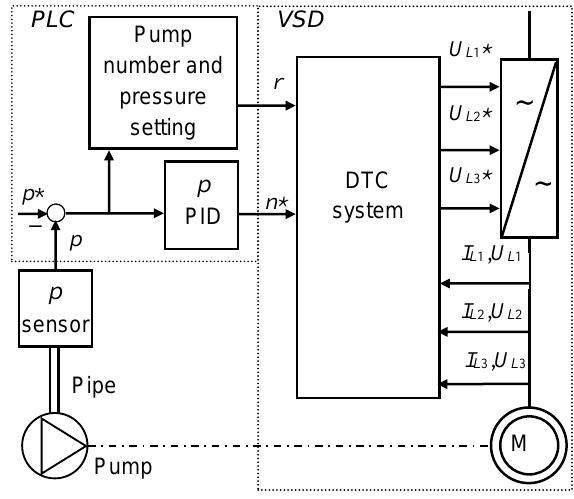
Fig. 4. Functional diagram of program-based pressure